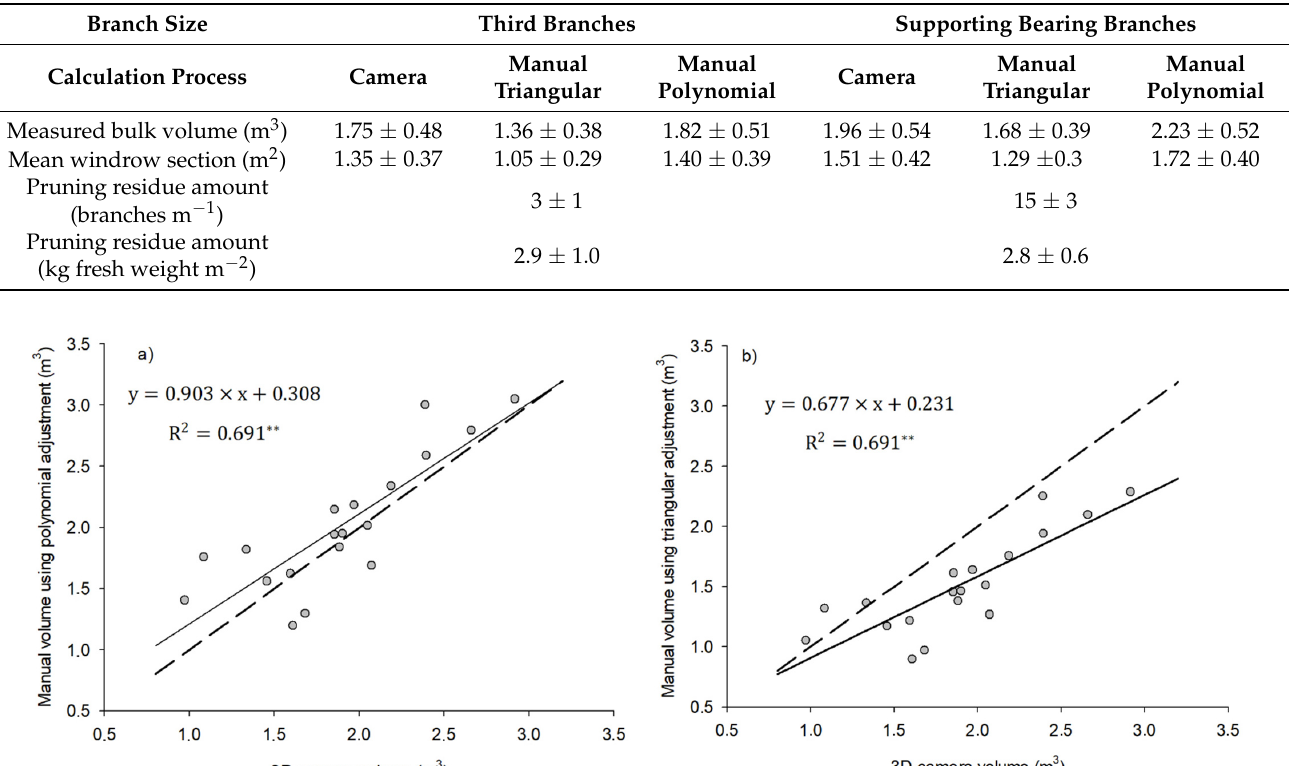
Table 4. Windrow bulk volumes and section for the different calculation processes and treatments.